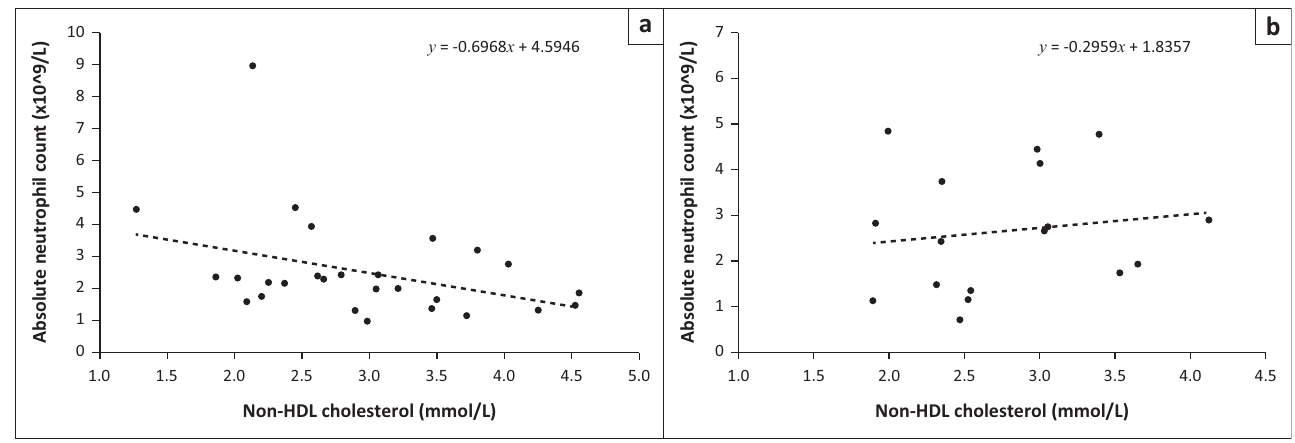
FIGURE 2: In Lu b -positive patients (a), non- high-density lipoprotein cholesterol was associated with neutrophil depletion. This effect was totally absent in Lu b -negative patients (b). (a: r = -0.369, p = 0.053, versus b: r = 0.143, p = 0.584). Julia Molefe Clinic, Gaborone, Botswana, December 2016 - February